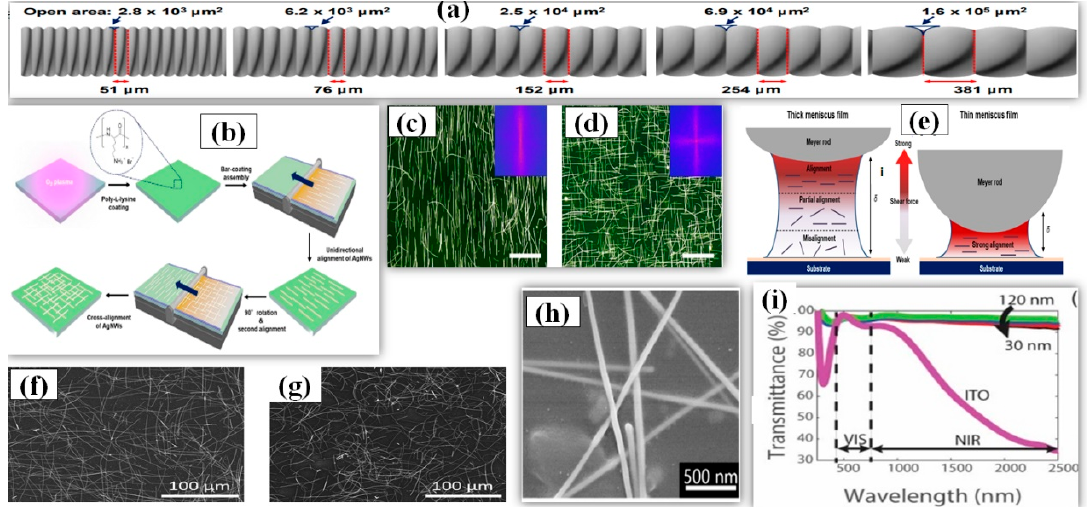
Figure 13. ( a ) Schematic illustration of the specifications of various Mayer rods. The rod number determines the diameter of wrapped wires and the open area. ( b ) A Schematic of procedure for the solution-processed bar-coating assembly to fabricate unidirectional and cross-aligned AgNW arrays. Before the bar-coating assembly, PLL solution is coated on O 2 plasma-treated target substrate to form amine groups on the surface. Consecutively, the meniscus dragging produces highly aligned AgNW arrays. The cross-aligned AgNW array is formed by repeating the bar-coating assembly in a perpendicular direction to that of the pre-aligned AgNW arrays. Fast Fourier transform (FFT) analyses of the optical micrographs, indicating the direction and uniformity of the aligned AgNW structures. ( c ) Unidirectionally aligned and ( d ) cross aligned AgNW arrays. The scale bars are 40 µ m. ( e ) Schematic showing the intensity distribution of shear force according to the variation of the height ( δ ) of meniscus (adapted from [180] with permission from ACS publications, 2017). SEM images of the AgNW networks deposited by ( f ) Mayer rod coating and ( g ) spray coating. R sh is the sheet resistance while the stated transmittance (T) is at 550 nm and relative to the transmittance of the bare glass (adapted from [122] with permission from Royal Society of Chemistry, 2020). ( h ) SEM image of AgNW bound by PEDOT:PSS, the illustration shows the high uniformity and continuous of the fabricated composite FTCE (adapted from [183] with permission from Royal Society of Chemistry, 2019) ( i ) Transmittance vs. wavelength for AgNW networks at nanowire diameters of 30 nm, 70 nm, 100 nm, and 120 nm. The transmittance of AgNW networks are much greater in the near-infrared region than commonly used indium tin oxide (adapted from [184] with permission from Royal Society of Chemistry,